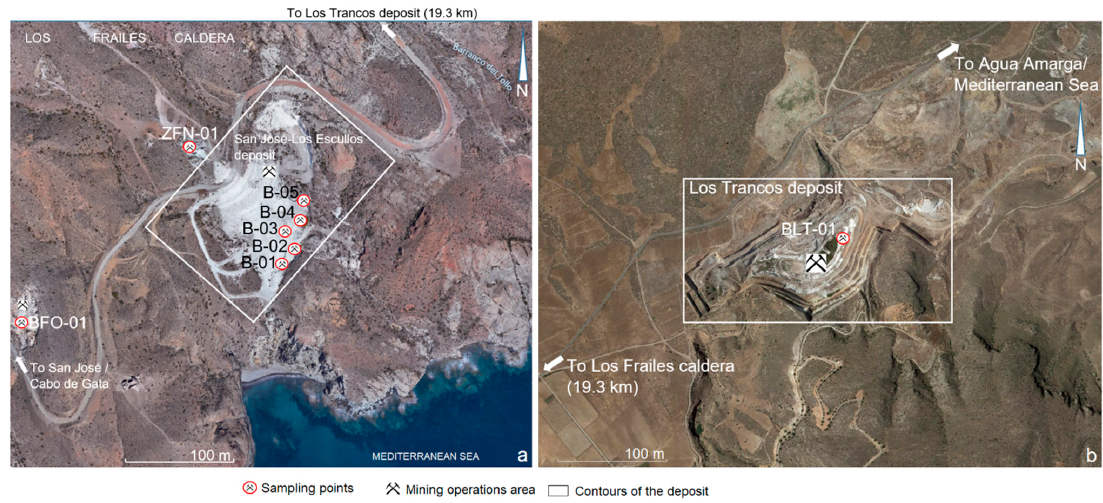
Figure 4. Location of sampling points: ( a ) samples taken in the San Jos é –Los Escullos deposit; ( b ) sample taken in the Los Trancos deposit